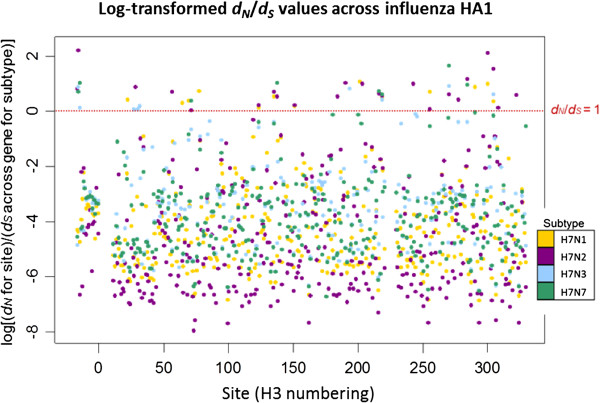
Log(dN/dS) values across avian influenza H7 HA1 sites, on different NA subtype backgrounds. The natural logarithm of the dN/dS values from was taken, so that sites with log(dN/dS) > 0 corresponded to dN/dS > 1, and sites with log(dN/dS) < 0 corresponded to dN/dS < 1 (the value log(dN/dS) = 0, i.e. dN/dS = 1, is shown as a dotted red line). The dN/dS values for each site are colour coded according to the background NA subtype. Codon sites correspond to the H3 numbering.